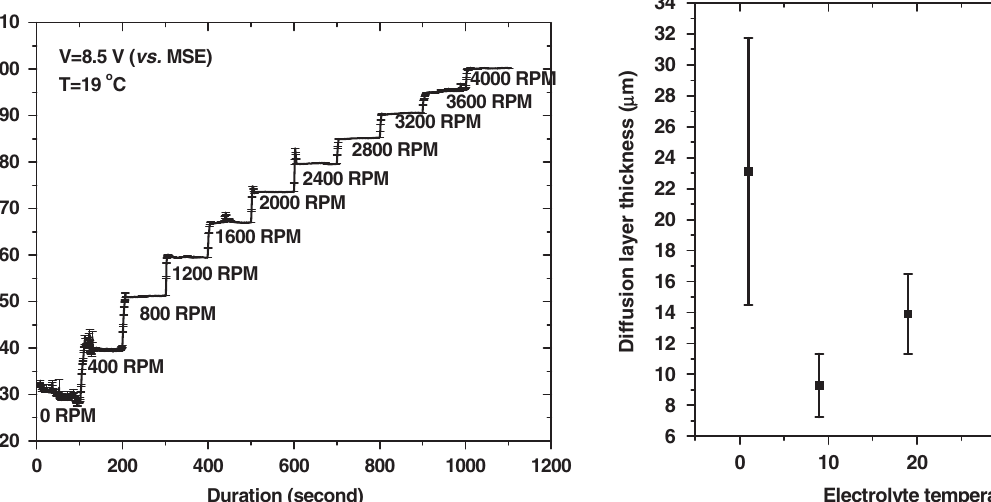
FIG. 4. The variation of limiting current density of Nb disk electrode with different rotation rate in 1:10 volume ratio HF and SO at 19 (cid:1) C at a potential 8.5 V (vs MSE). H 2 4